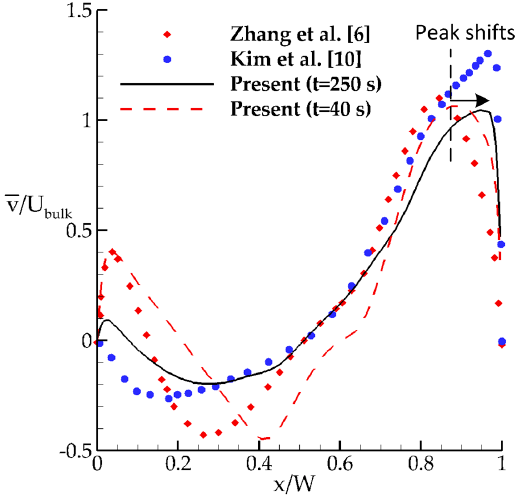
Figure 6. Comparisons of time ‐ averaged vertical velocity profiles on Line 3.